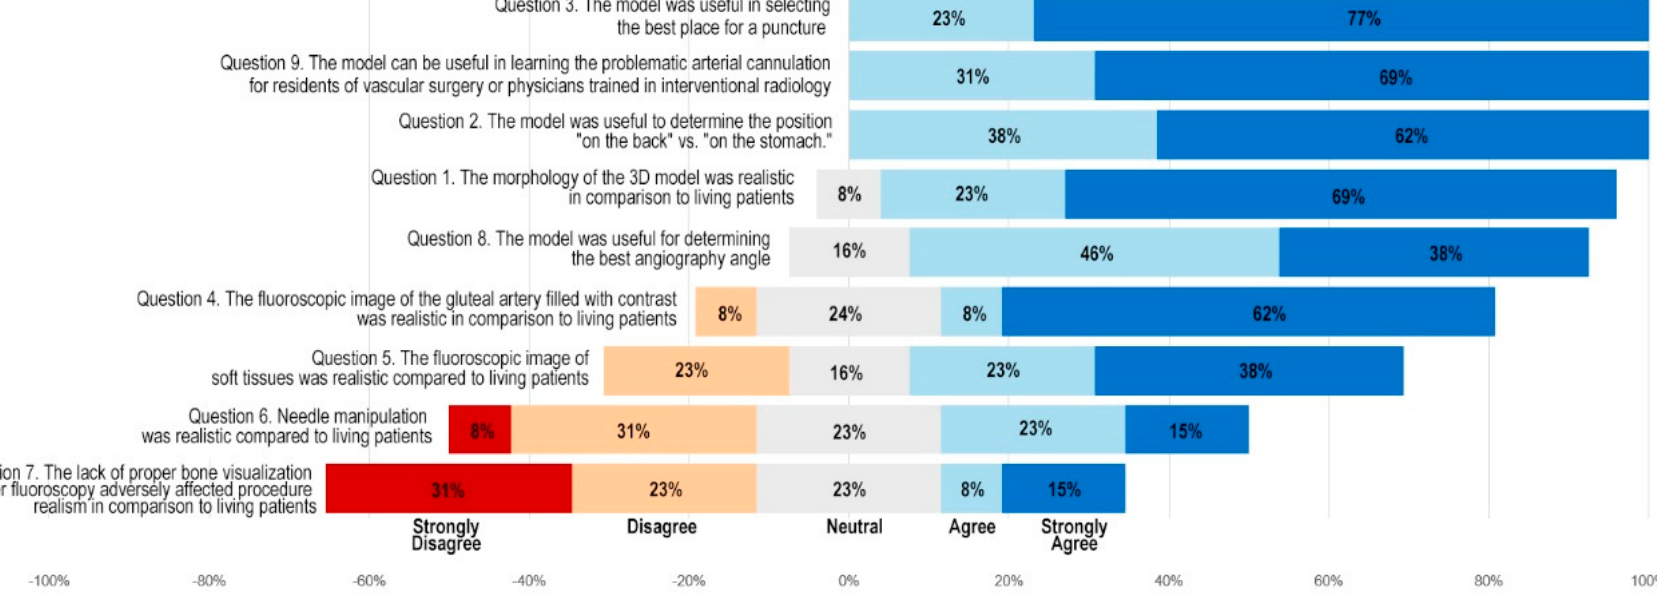
Figure 3. Results of a questionnaire presented as a diverging Likert scale summary.